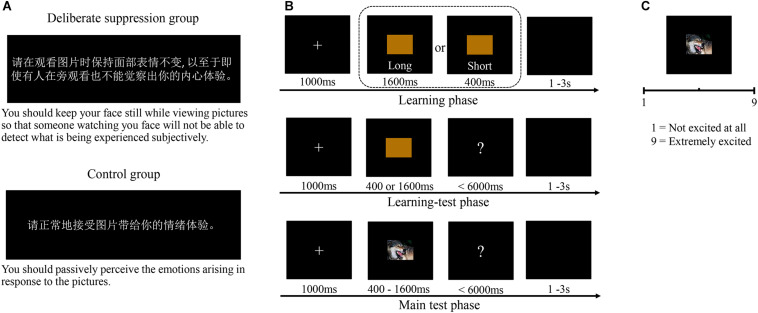
The procedure of Experiment 1. (A) The instructions of deliberate suppression group and control group. (B) Schematic illustration of the temporal bisection task. (C) Schematic illustration of the arousal assessment.